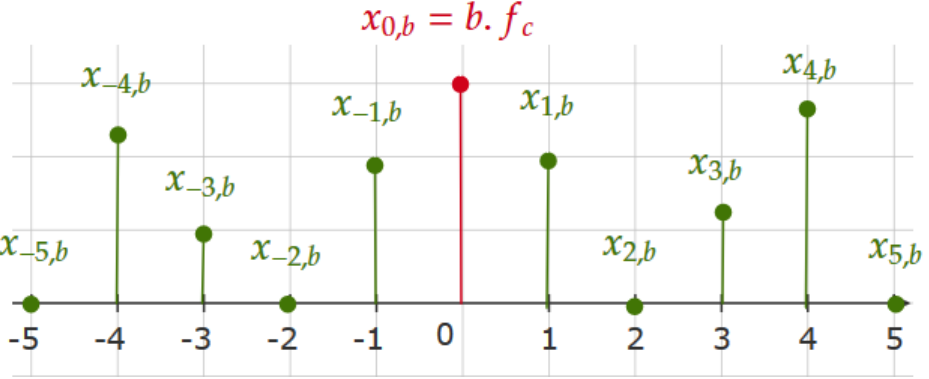
Figure 1. Spectrum of a typical modulated